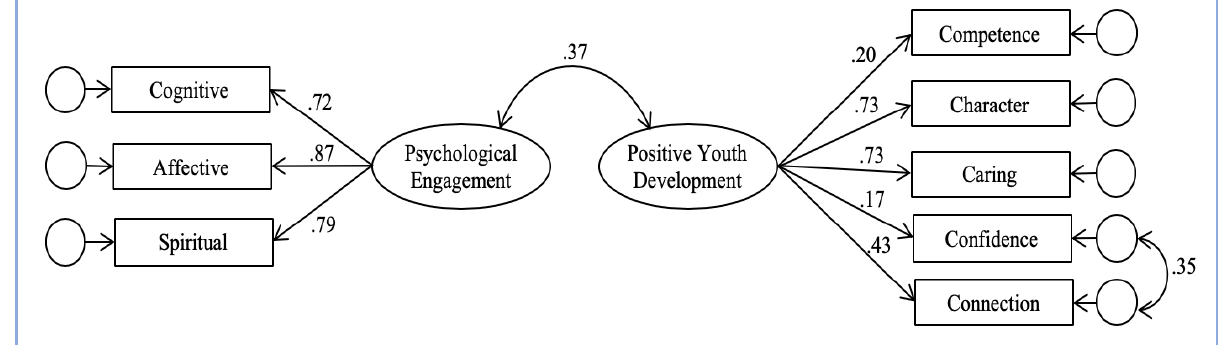
Figure A1. Measurement Model of Psychological Engagement and Positive Youth